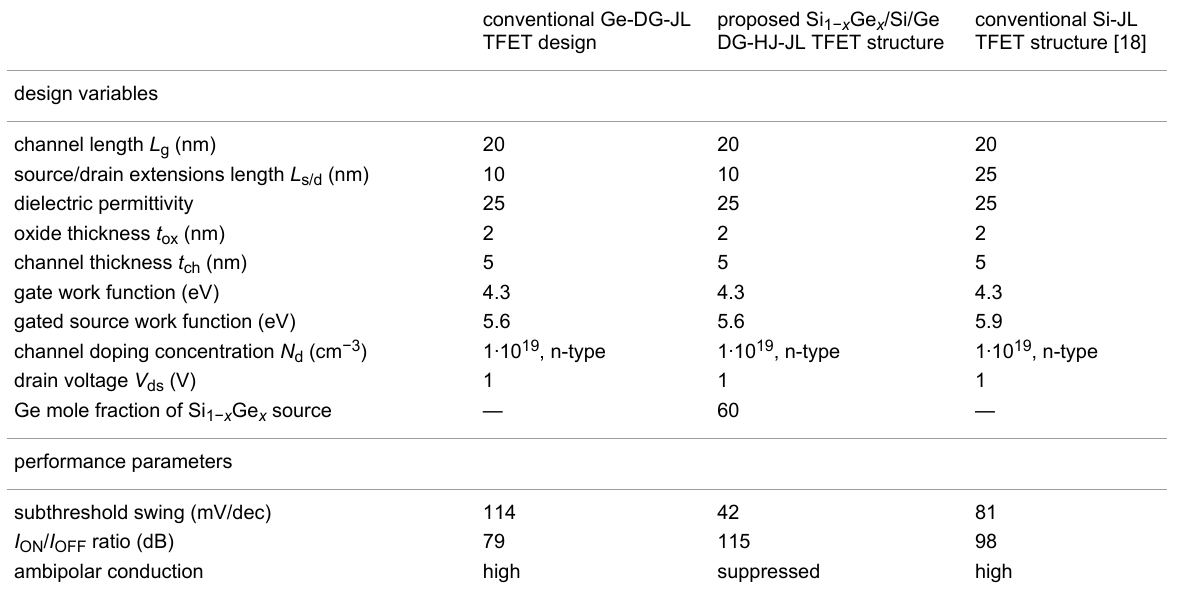
Table 1: Overall electrical comparison of